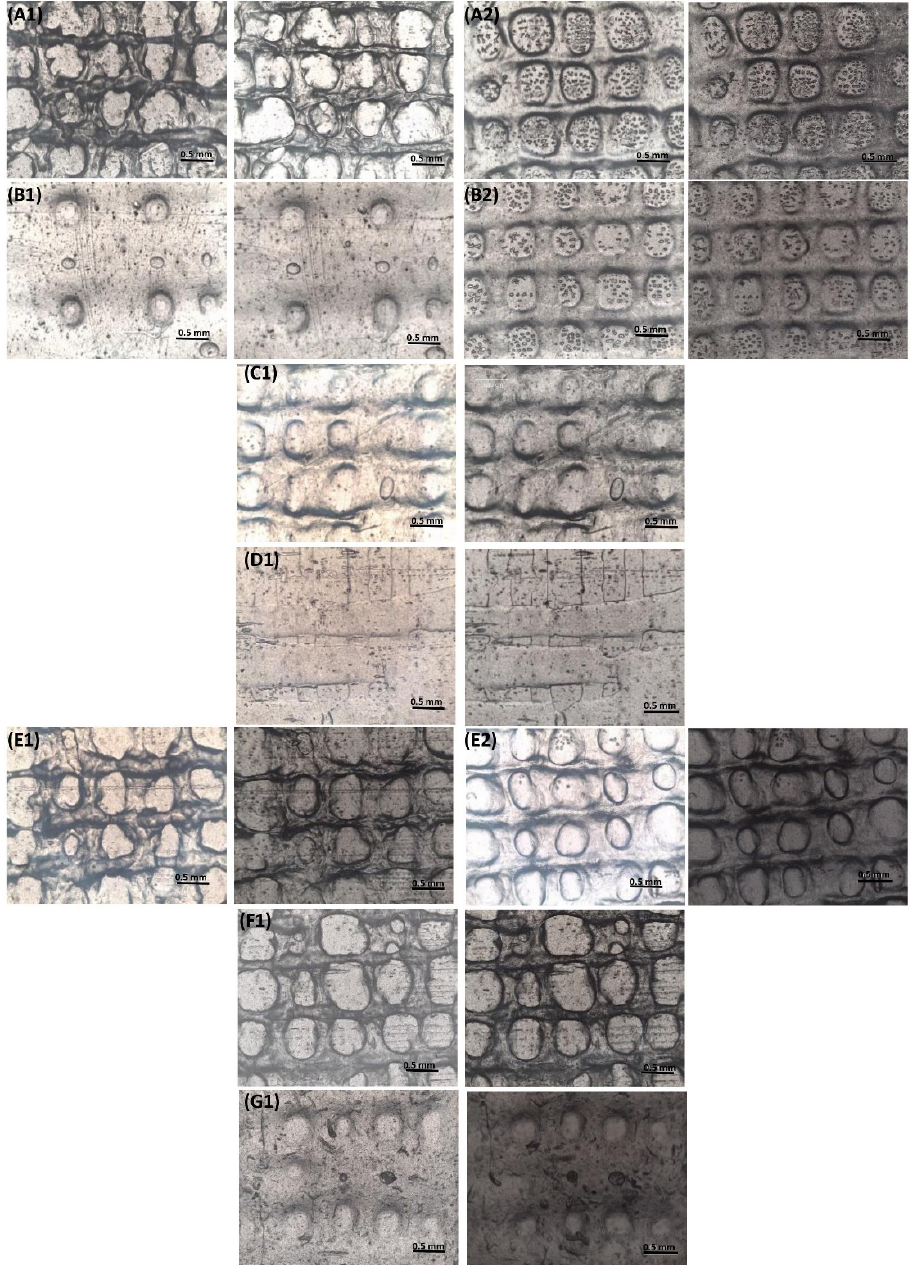
Figure 6. Microscopic images of the meshes after printing (left for each group) and after vacuum drying (right of each group) of the formulations, scale bar = 0.5 mm ( A) G, ( B ) GB0.5, ( C ) GB1, ( D ) GB2, ( E ) GS0.5, ( F ) GS1, and ( G ) GS2, where 1 refers to meshes printed with 25 G and 2 refers to those printed with 27 G needles. Images obtained of the meshes printed with 27 G needles showed smoother printed lines and well-defined pores when compared to the meshes printed using 25 G needles. GelMA meshes printed with 25 G needles had poorly printed lines due to the increased thickness of the extruded filament. The high viscosity of GS2 inks was difficult to extrude resulting in an inconsistent filament, due to which the lines of these meshes were not